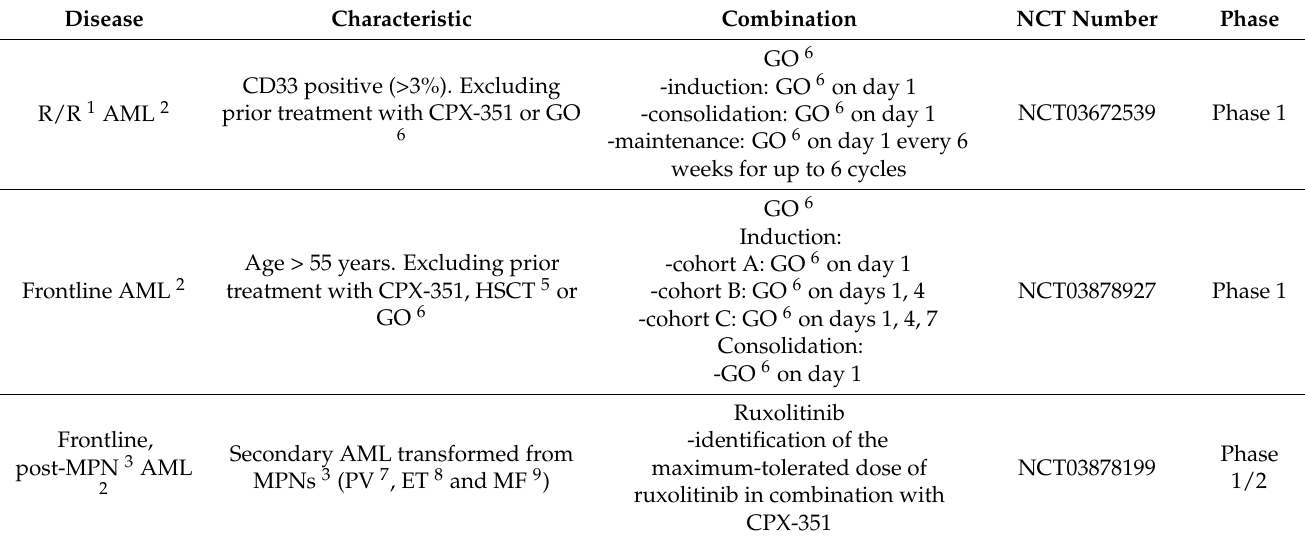
Table 3. Ongoing trials including CPX-351 in combination with other